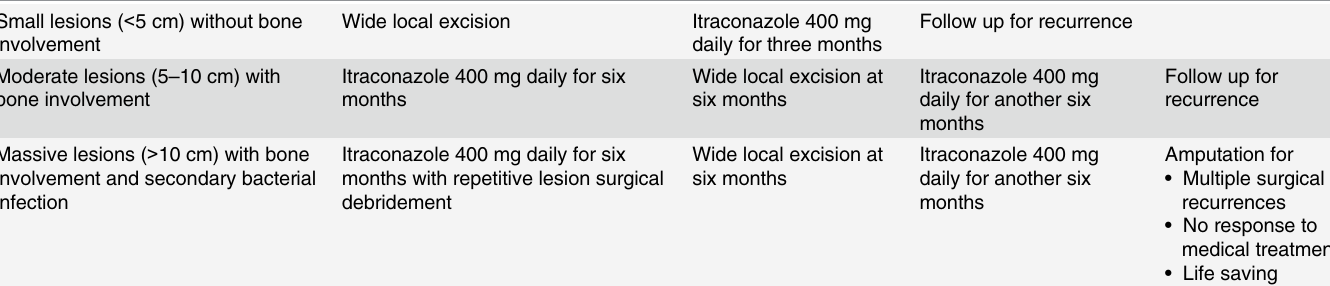
Table 1. Mycetoma treatment guidelines.